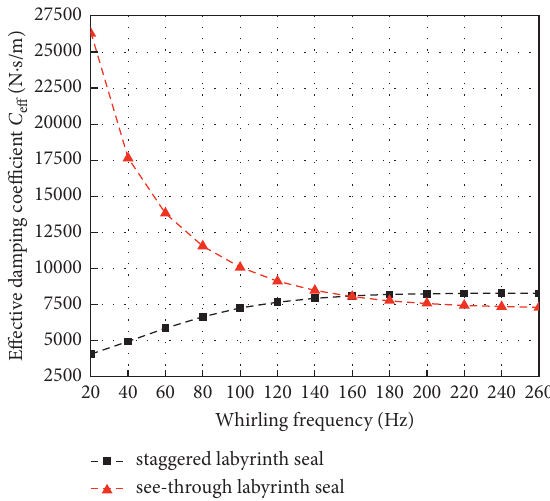
Figure 31: Effective damping coefficient vs. whirling